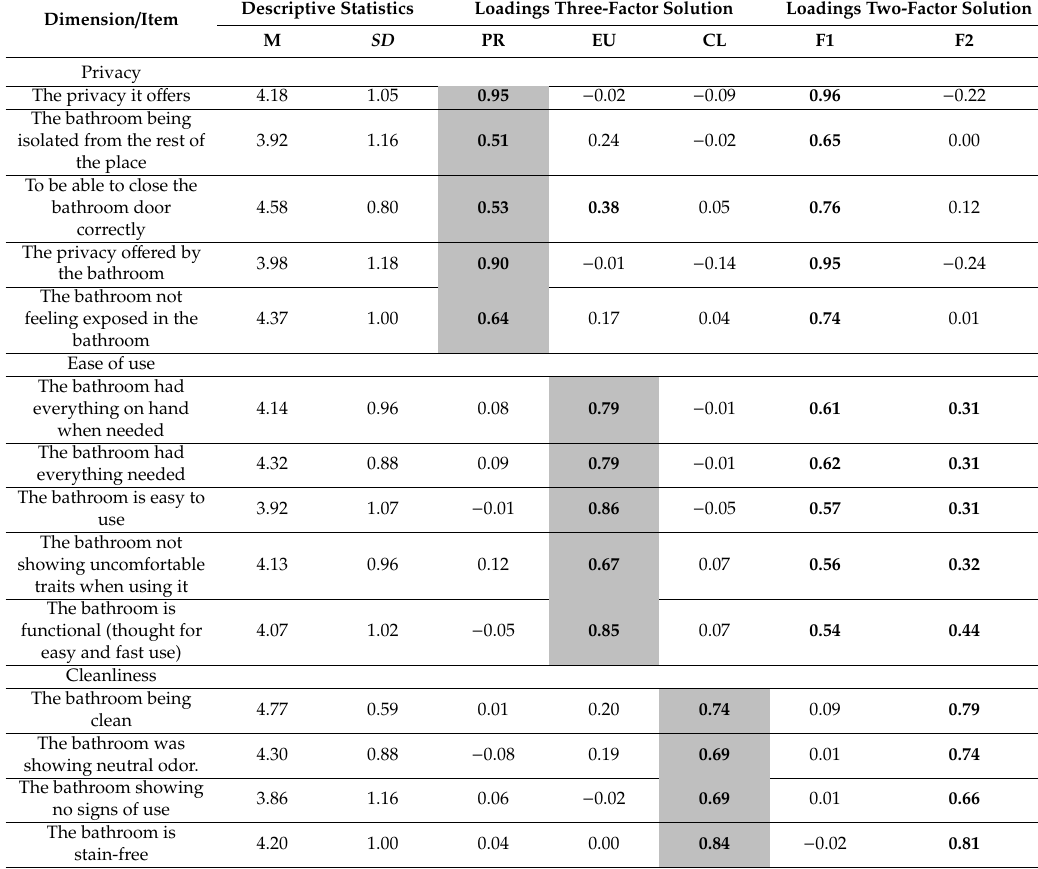
Table 1. Items, mean score and item loadings of the Public Bathroom Perception Scale (PBPS) for three- and two-factor